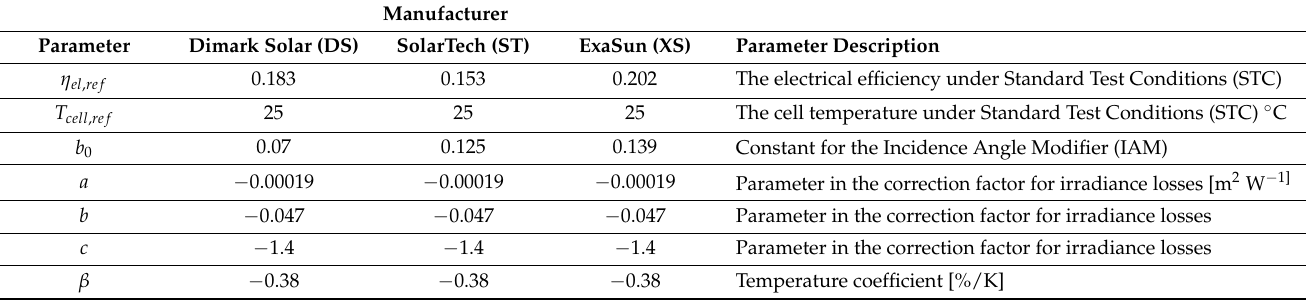
Table 8. Electrical model parameters for the different PVT collectors. Adopted values from [19]. Values for a , b and c are supplied by the manufacturer of the PV-panels.